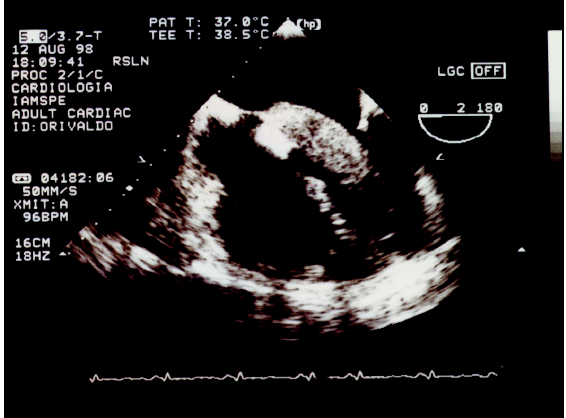
Fig. 3 - Ecocardiograma bidimensional pré-operatório exibindo grande massa tumoral pediculada (mixoma), originando-se do septo interatrial e prolapsando-se, através da valva mitral, para a cavidade ventricular esquerda durante a